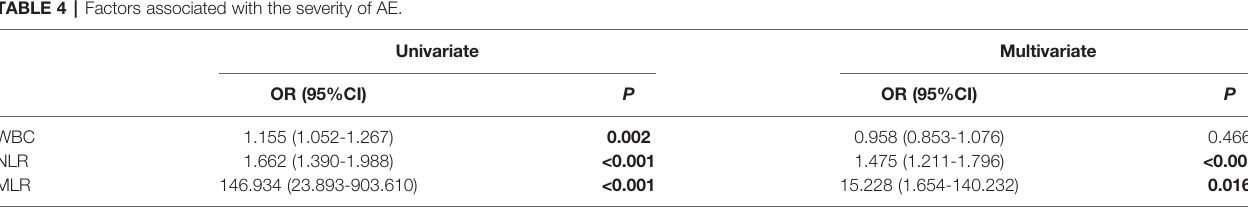
TABLE 4 | Factors associated with the severity of